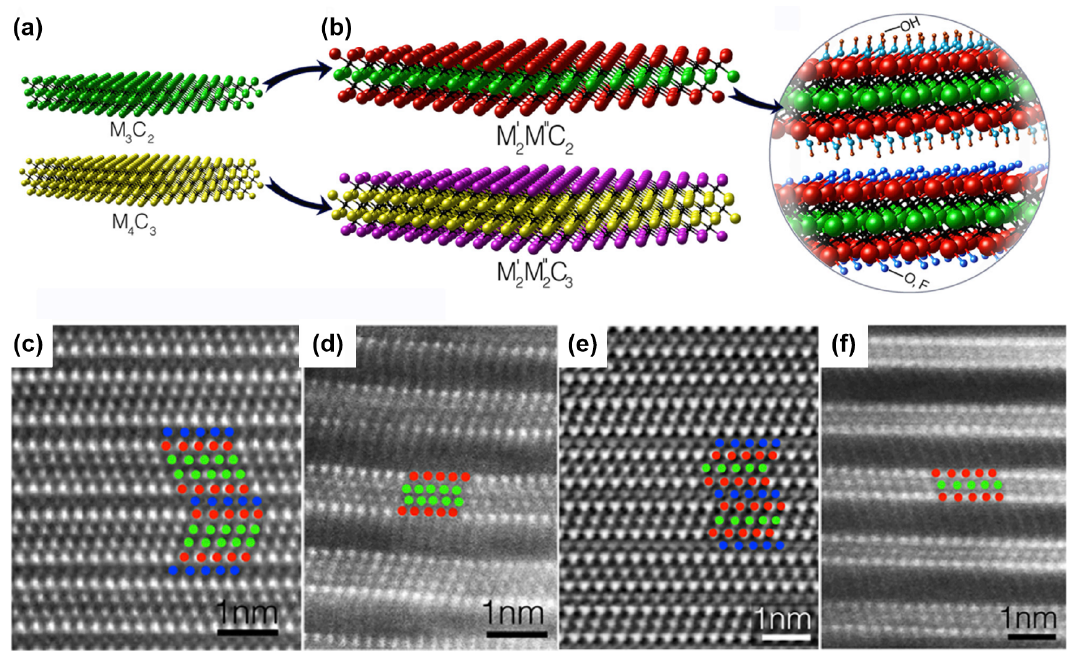
Figure 13. ( a ) Schematic of currently available single-transition-metal MXenes. ( b ) Schematic of double- transition-metal MXenes. ( c – f ) HRSTEM images of ( c ) Mo 2 Ti 2 AlC 3 , ( d ) Mo 2 Ti 2 C 3 , ( e ) Mo 2 TiAlC 2 , and ( f ) Mo 2 TiC 2 T x . Red, green, blue, and black circles represent Mo, Ti, Al, and C atoms, respectively. Reproduced with permission from reference [186]. Copyright 2016,